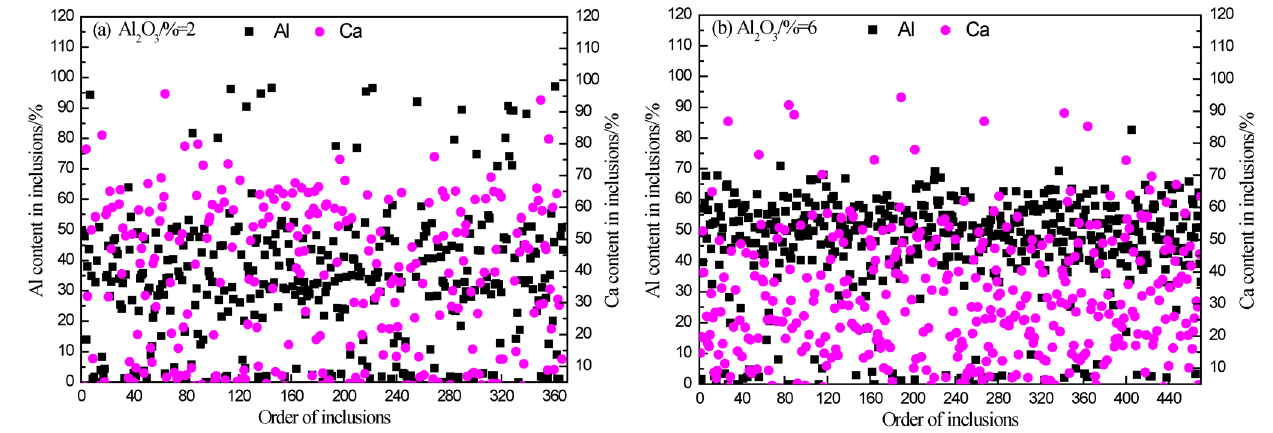
Figure 11. Effect of Al 2 O 3 content in slag on inclusion composition of electroslag ingots. ( a ) Al 2 O 3 content in the slag is 2%; ( b ) Al 2 O 3 content in the slag is 6%.